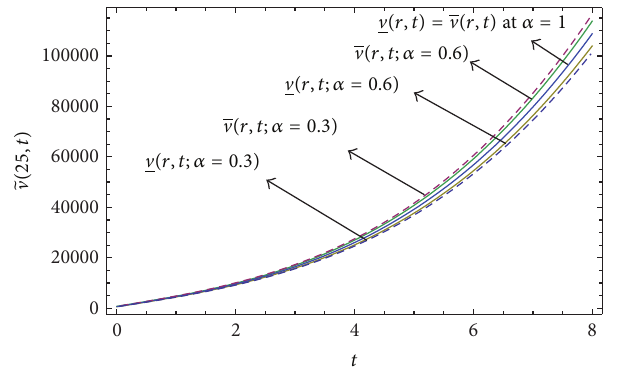
Figure 10: Interval solution of Case 5.